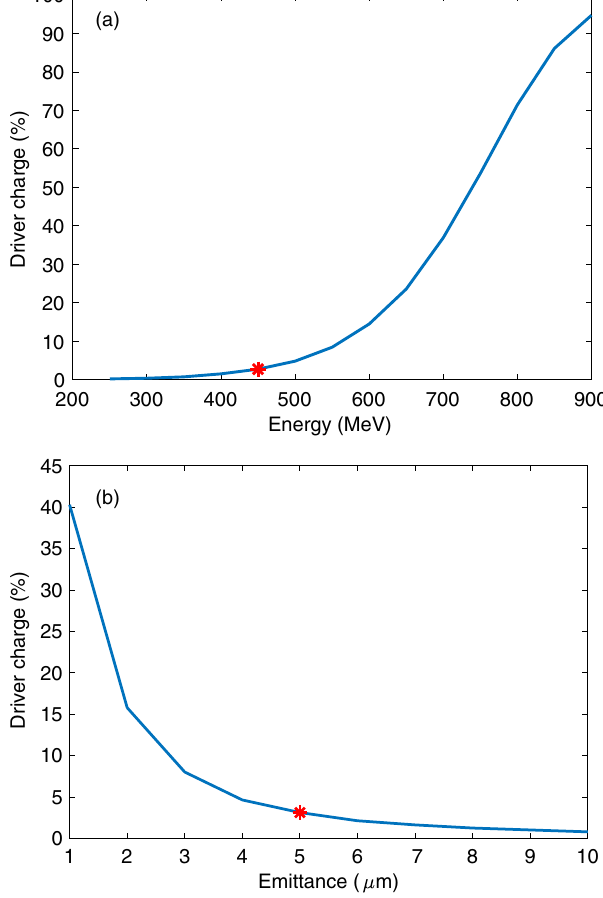
FIG. 10. Driver charge at the end of the system for different driver energies (a) and normalized emittances (b). The red asterisks show the reference case described in Table